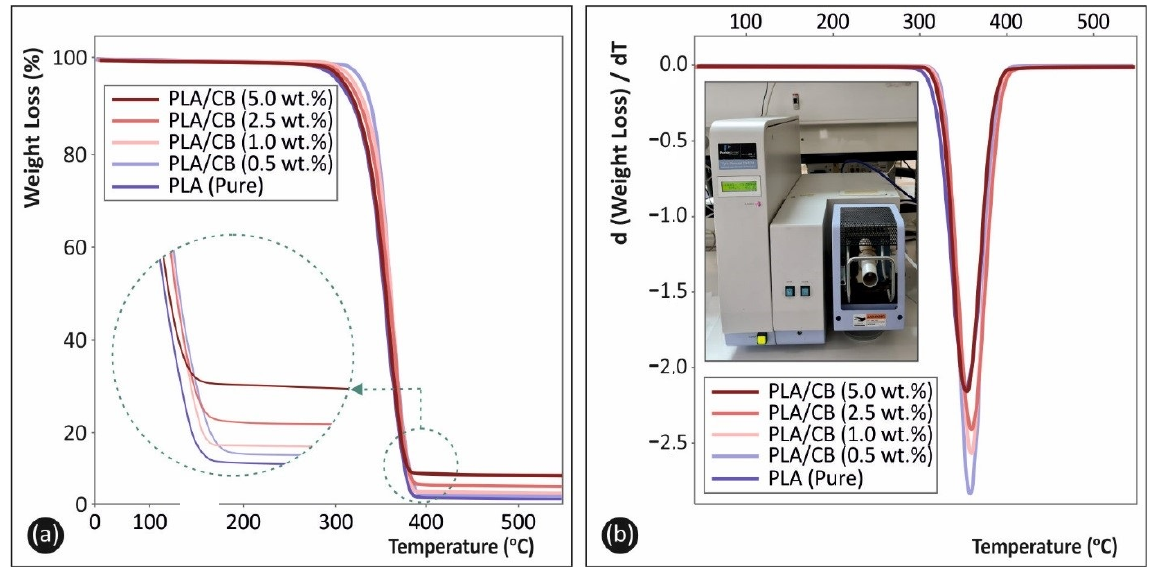
Figure 4. ( a ) Thermogravimetric Analysis (TGA) and ( b ) Differential Thermogravimetry (DTG) plots of 3D printed neat PLA and PLA/CB nanocomposites (inset TGA scan in Figure 4a shows the nanocomposites’ remnant due to CB, as well as the increased thermal stability induced by the CB nanofiller at all particle loadings).